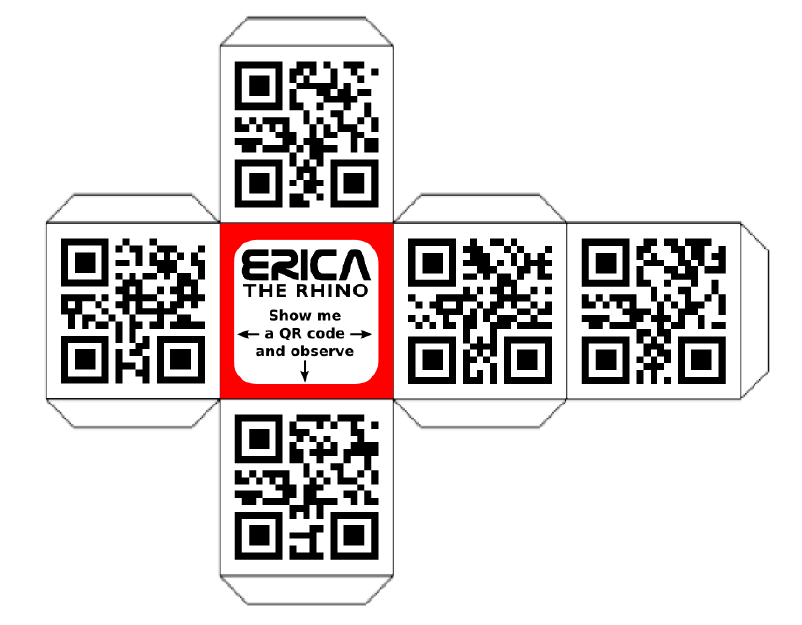
Figure 13. A two-dimensional net for a QR cube developed to aid interacting with